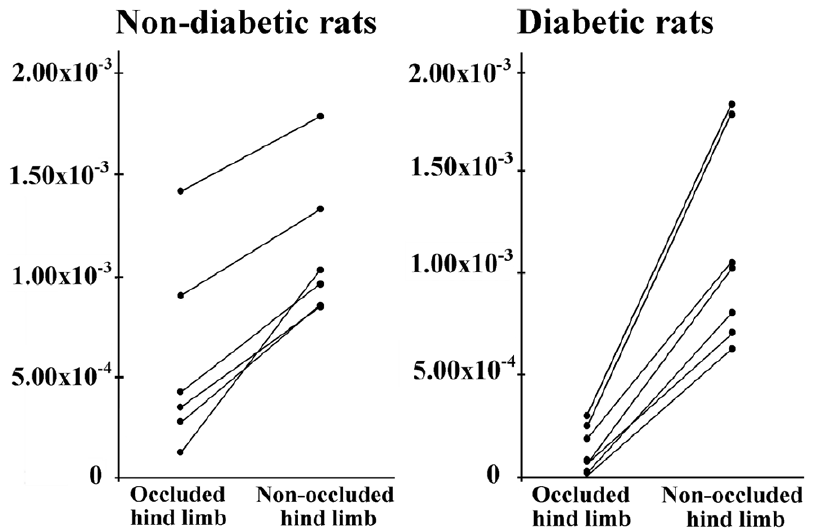
Figure 5. Individual values of tCr/water in each limb. Individual values of tCr/water in the occluded and non-occluded limbs for each non- diabetic (left side) and diabetic (right side) rat (joined by the continuous lines).